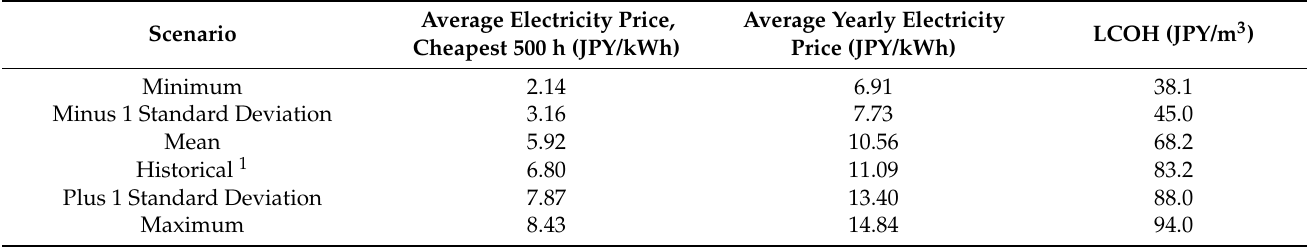
Table 6. Impacts of the distribution tail on